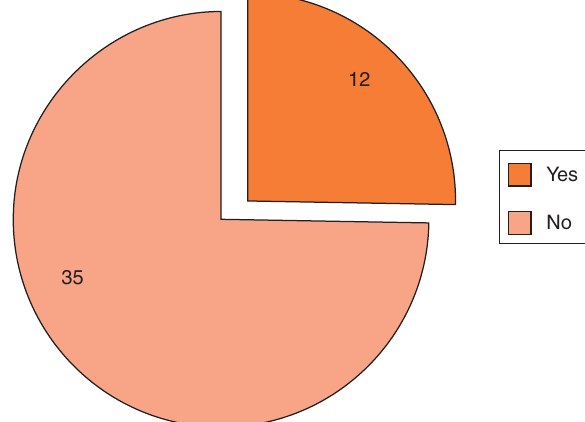
Figure 4 Routinely assess hearing in children ( n = 47).